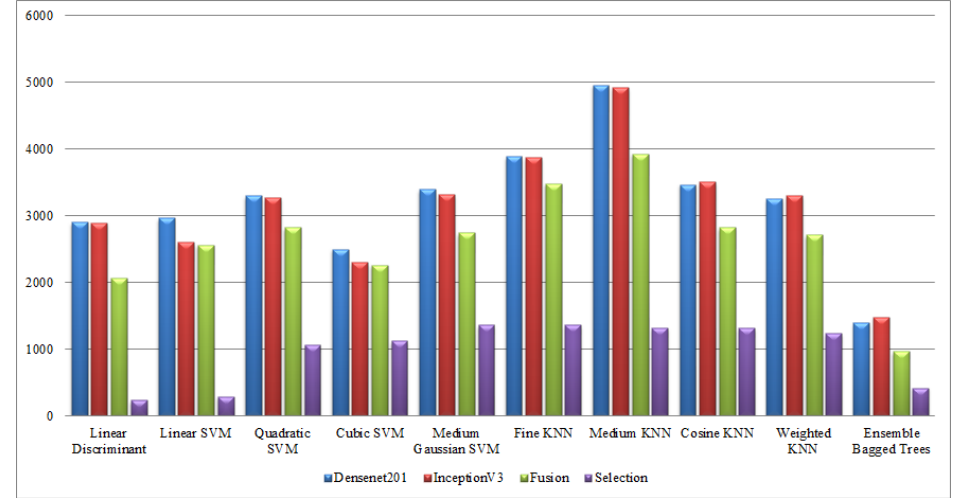
Figure 18. Computational time-based comparison of middle steps on WVU dataset.